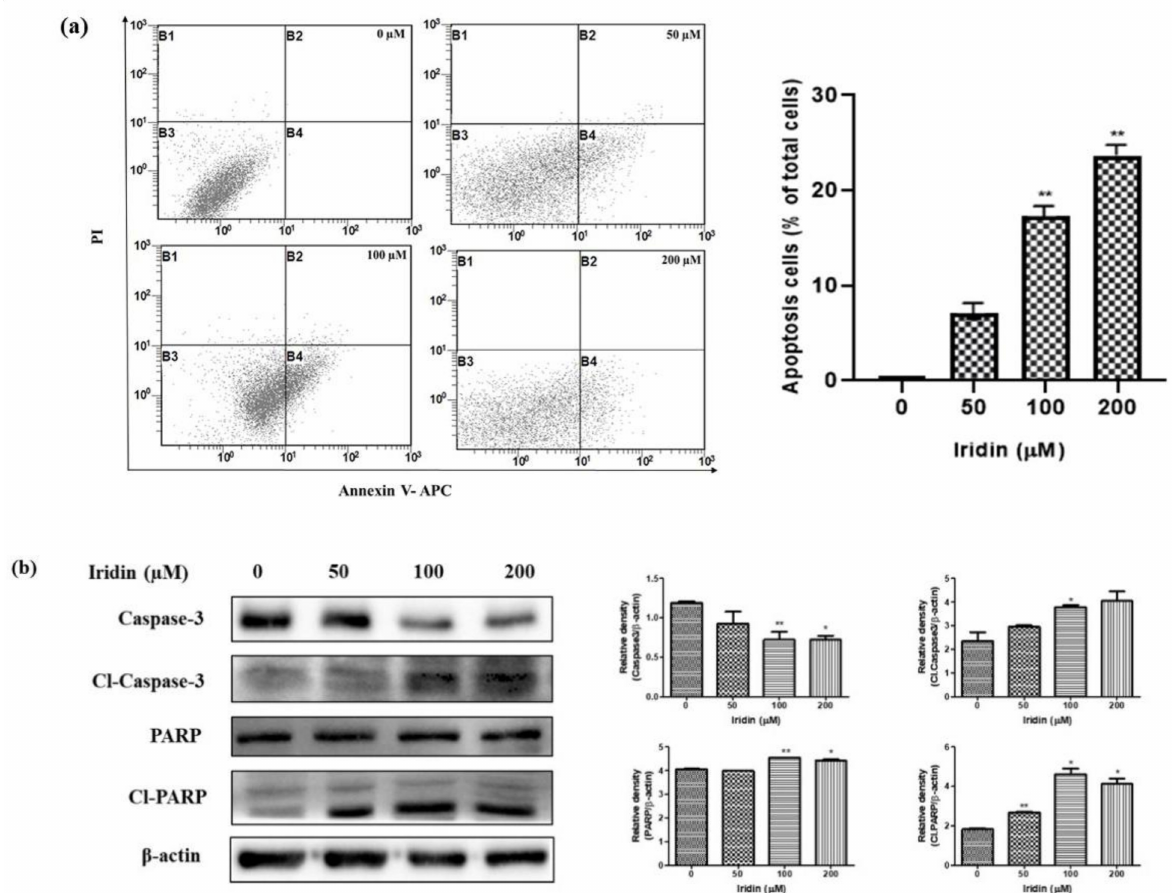
Figure 3. Iridin induces apoptosis in AGS cells. ( a ) AGS cells were treated with indicated concentrations with iridin (0, 50, 100, and 200 µ M) for 48 h. Double staining with allophycocyanin (APC/Annexin V and propidium iodide (PI) was performed to analyze by flow cytometry. ( b ) The cells were treated with iridin at indicated concentrations (0, 50, 100, and 200 µ M) for 48 h. Total cell lysates were separated in sodium dodecyl sulfate (SDS)-polyacrylamide gels and blotted onto polyvinylidene difluoride (PVDF) membranes. The membranes were probed with cleaved caspase-3 (Cl-Caspase-3), PARP, cleaved- polymeric adenosine diphosphate ribose (PARP), and β -actin antibodies. The proteins were visualized using the detection system of Electrochemiluminescence (ECL). Bar and error bar values represent the mean ± standard error of the mean (SEM) of three separate datasets. * p < 0.05 vs. control, ** p < 0.01 vs. control.